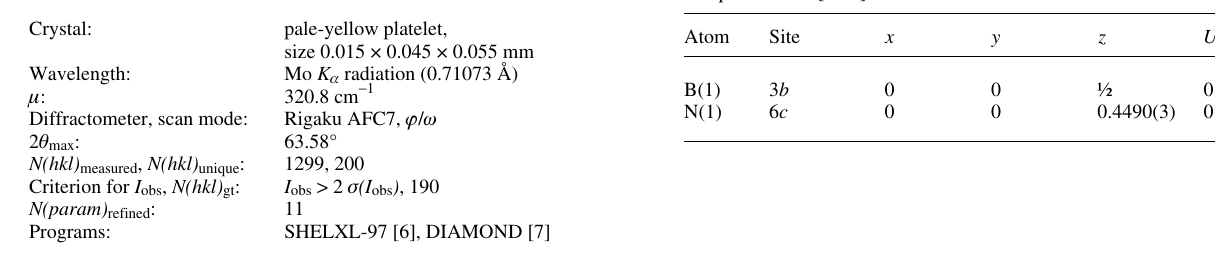
Table 1. Data collection and handling.